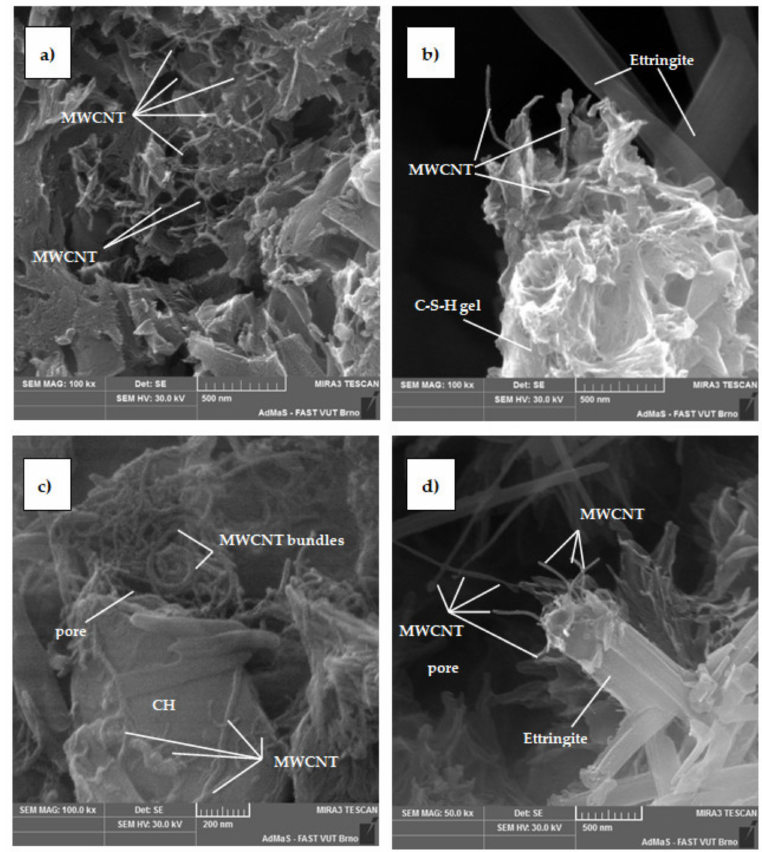
Figure 4. Morphology of cement hydration products with nanotubes at an age of 3 days: ( a ) general view of the distribution of nanotubes among cement hydration products; ( b ) overgrowth of nanotubes by C–S–H gel; ( c ) distribution of nanotubes on the surface of portlandite (CH) and filling of gel pores by nanotube bundles; ( d ) overgrowth of nanotubes on